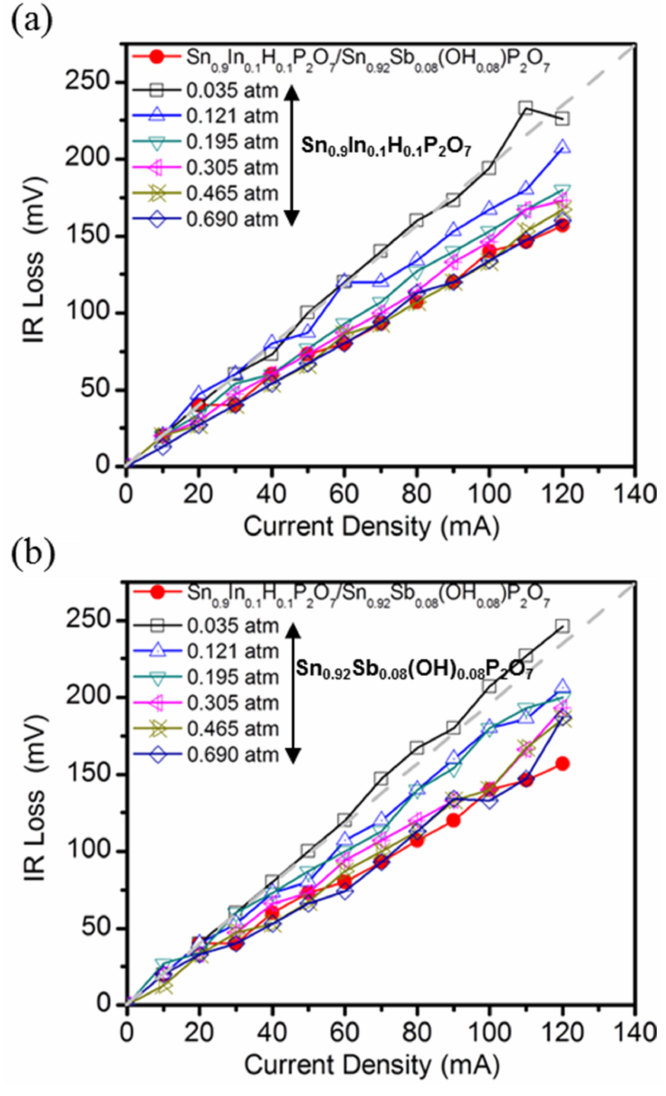
Figure 6. IR losses at different P H 2 O conditions of ( a ) Sn 0.9 In 0.1 H 0.1 P 2 O 7 and ( b ) Sn 0.92 Sb 0.08 (OH) 0.08 P 2 O 7 membranes as a function of current density. Red circle lines indicate IR losses of Sn 0.9 In 0.1 H 0.1 P 2 O 7 /Sn 0.92 Sb 0.08 (OH) 0.08 P 2 O 7 membrane at a P H 2 O of 0.035